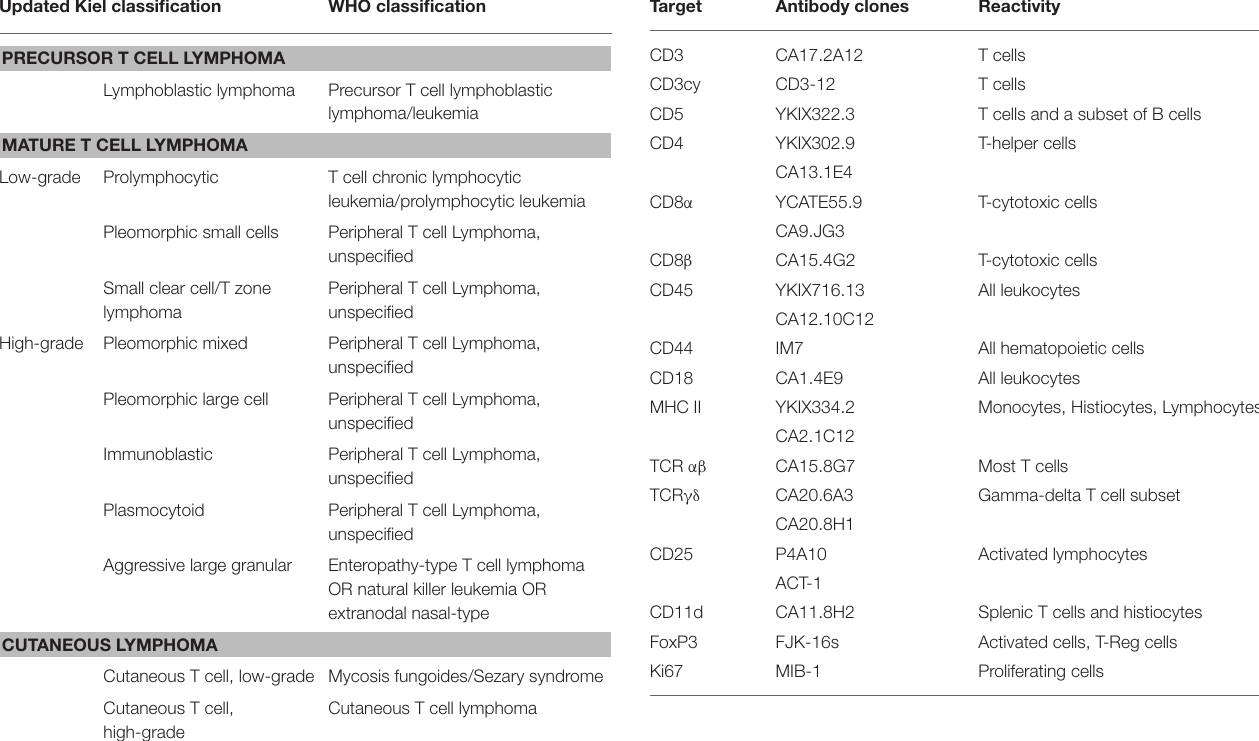
TABLE 1 | Possible correlation between updated Kiel classification and WHO classification for TCLs according to Ponce et al. (3). Updated Kiel classification